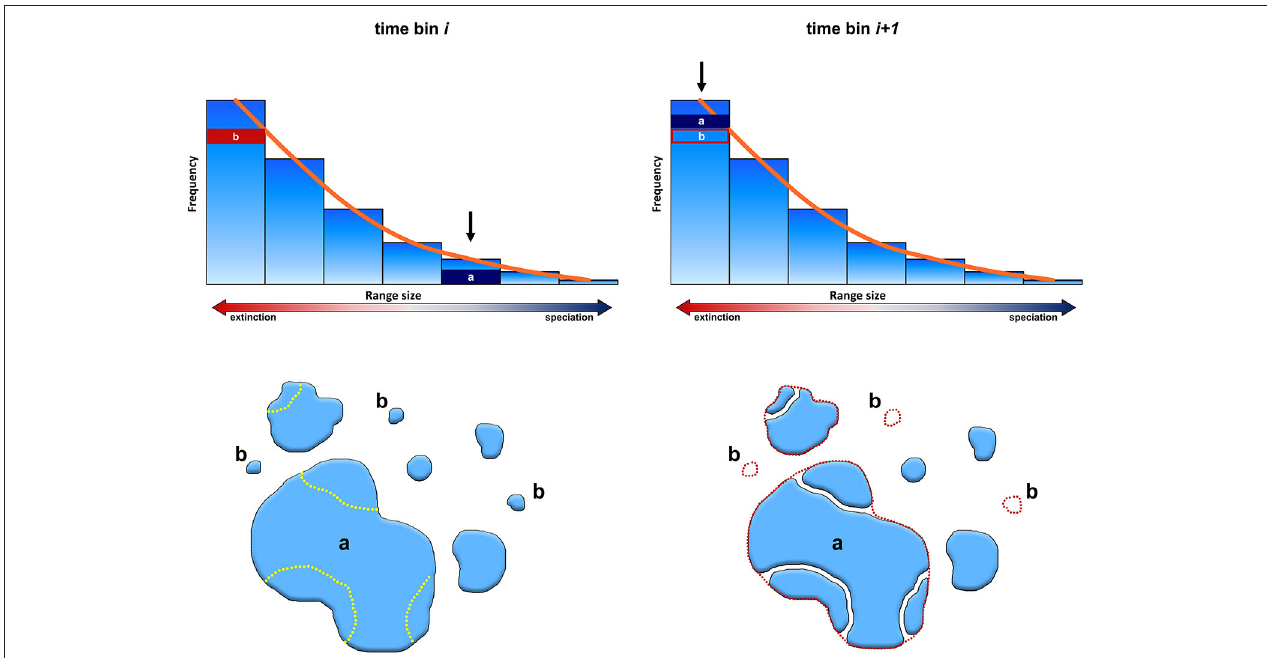
FIGURE 3 | Evolution of the frequency range size distribution over two consecutive time bins. According to our results, during time i (left column) large-ranged species (dark blue box, indicated with the lower case letter a) have higher probability of speciation, and tend to split at their range periphery giving small ranged daughter species (lower row, left). On the contrary, small ranged species (indicated with the lower case letter b) have higher extinction rates. As a consequence, in the succeeding time bin ( i + 1 right column) species deriving from “a” occupy the small-range size class, replacing species “b,” now extinct.